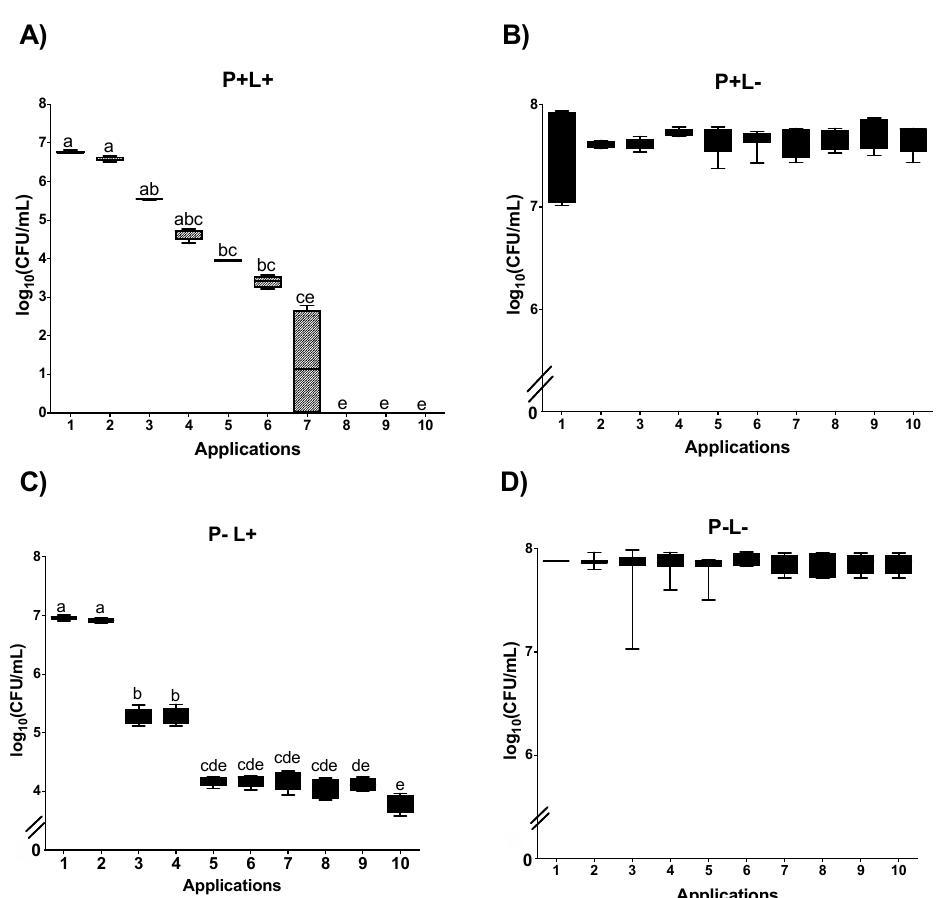
Figure 7. Log 10 values (CFU/mL) of C. albicans biofilms submitted to ( A ) aPDT (P+L+), ( B ) PDZ (P+L − ), ( C ) light (P − L+), and ( D ) experiment control (P − L − ) grown in fluconazole. Upper limit of the box: third quartile; lower limit of the box: first quartile; error bars: minimum and maximum values. Different letters (a; b; c; d; e) denote statistical differences between columns (applications) according to Dunn’s post-test ( p < 0.05) ( n = 12).